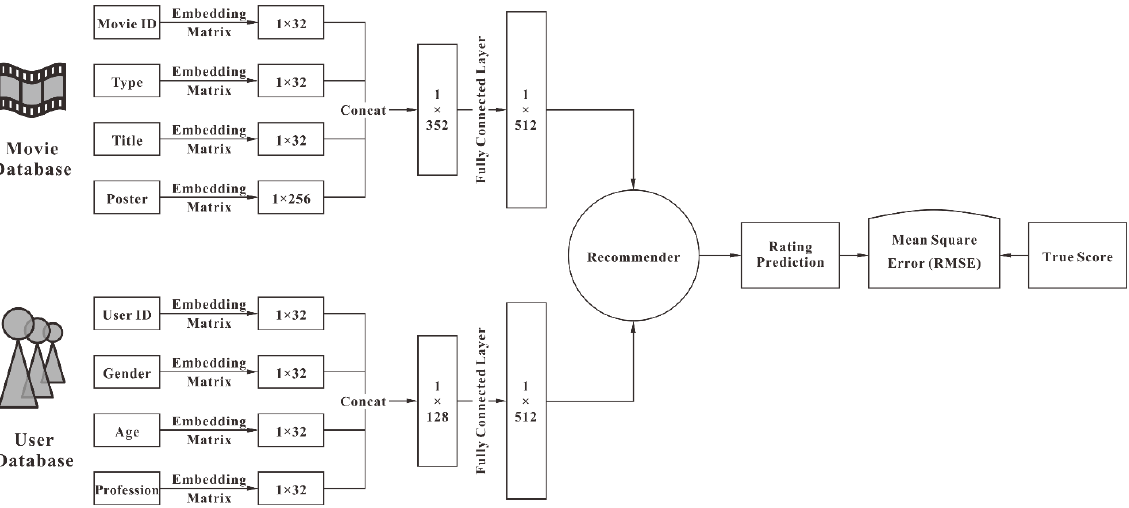
Figure 4. Score prediction model of the movie recommendation system based on neural network.